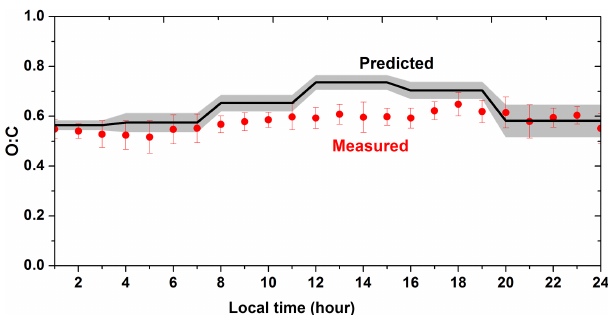
Figure 2. Average O : C diurnal evolution at the ground level in San Pietro Capofiume for the one-bin simulation as an example. The black line shows the 4h model average predictions for all simulated days (six plateaus from 4h of model predictions) and the shaded area corresponds to 1 standard deviation. The red symbols represent the ground AMS measurements and the error bars correspond to 1 standard deviation.